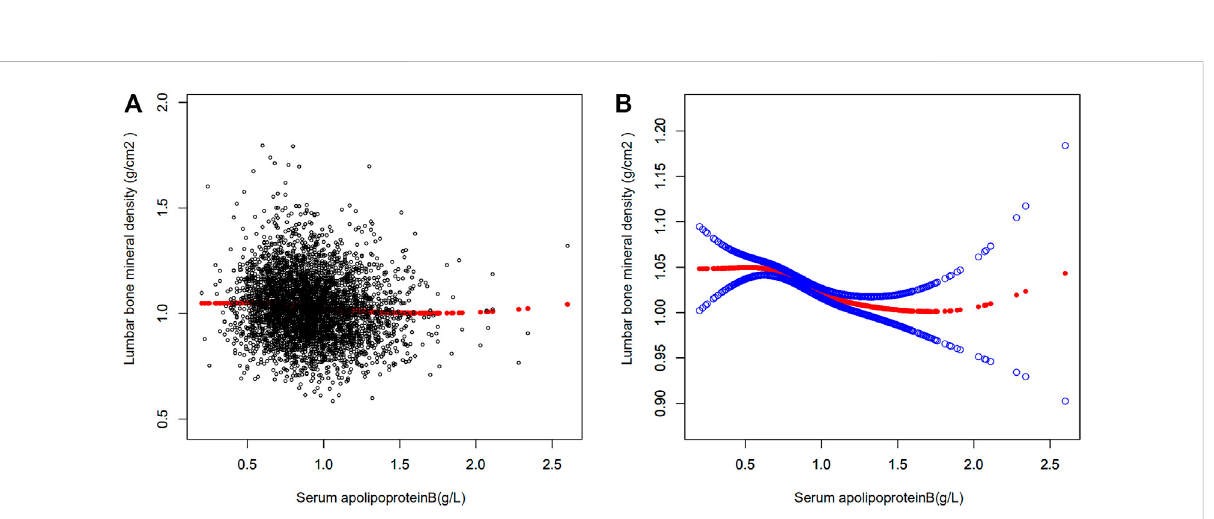
FIGURE 2 Relationship between serum apolipoprotein B and bone mineral density. (A) Each black dot represents a sample. (B) Red curves represent smoothed curves between variables, the blue bands represents the 95% con fi dence interval of the fi tted curve (adjusted for age, race/ethnicity, sex, vigorousrecreationalactivities,smokedatleast100cigarettes inlife,incometopovertyratio,bloodureanitrogen, serumcalcium,serum potassium, serum sodium, serum phosphorus, total protein, serum uric acid, body mass